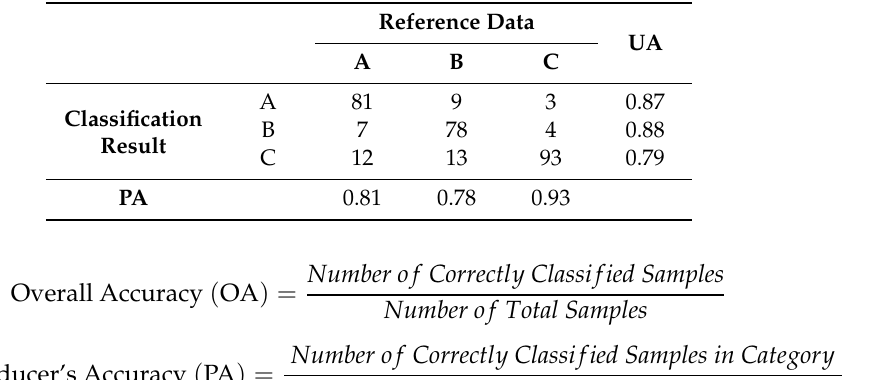
Table 1. Example error matrix. OA = 0.84, QD = 0.06, AD = 0.10, Kappa =